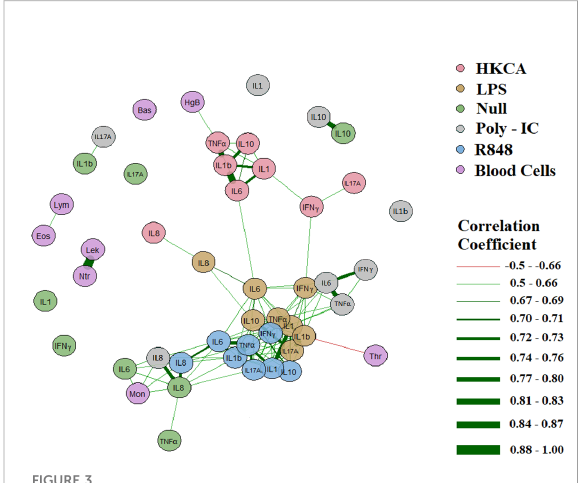
FIGURE 3 Correlation of blood cell counts and cytokines in 37 NSCLC patients based on baseline data before treatment. Only correlations with an alpha value of p=0.05 and a correlation coef fi cient of >0.5 or ≤ 0.5 are plottedas connecting lines: Green signifying a positive and red a negative correlation. Line thickness signify a correlation coef fi cient from -1 to 1. Mon: Monocytes, Thr: Thrombocytes, Lek: Leukocytes, Ntr: Neutrocytes, Eos: Eosinophil, Lym: Lymphocytes, Bas: Basophilocytes, HgB: Hemoglobin. All blood cells are purple, while cytokines are in different colors depending on the